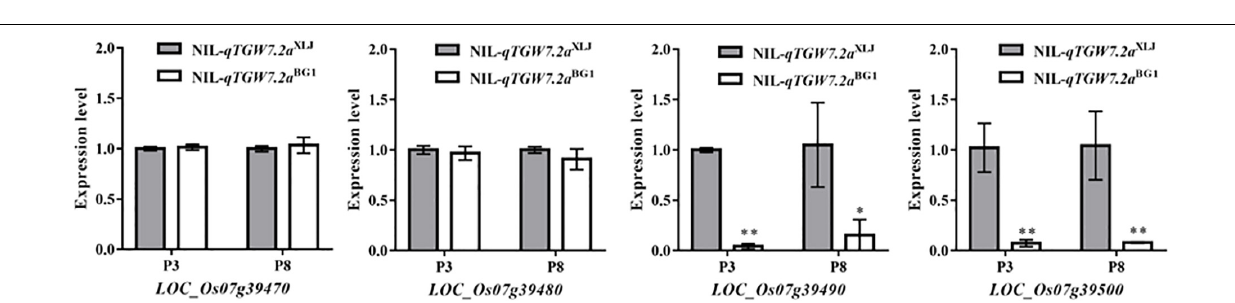
FIGURE 3 | Scanning electron microscopic observation and analysis of the glume. (A) Scanning electron micrograph of the outer glume epidermal cells between NIL- qTGW7.2a XLJ and NIL- qTGW7.2a BG 1 . Bar = 100 µ m. (B) Cell number of outer epidermal cells. (C) Cell length of outer epidermal cells. (D) Cell width of outer epidermal cells. Data are given as mean ± SD. Student’s t -test was used to generate P value; ∗∗ P < 0.01. Red dot, the number of grains used to calculate cell number in (B) , and cell numbers to measure cell length (C) and cell width (D) .